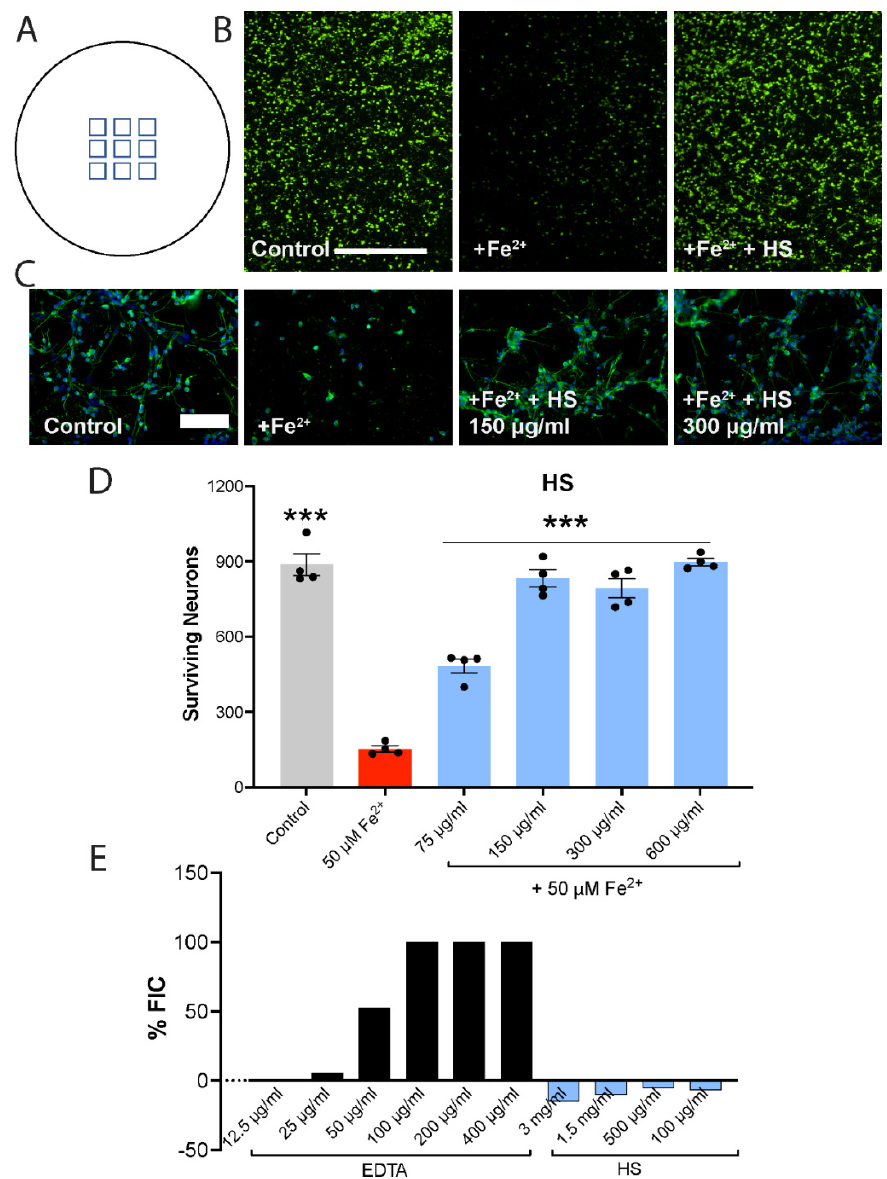
Figure 1. The killing of human neurons by ferrous iron is prevented by HS. ( A ) Schematic repre- sentation of the 9 (or 12 in some experiments) fields per view per well of a 96-well plate that